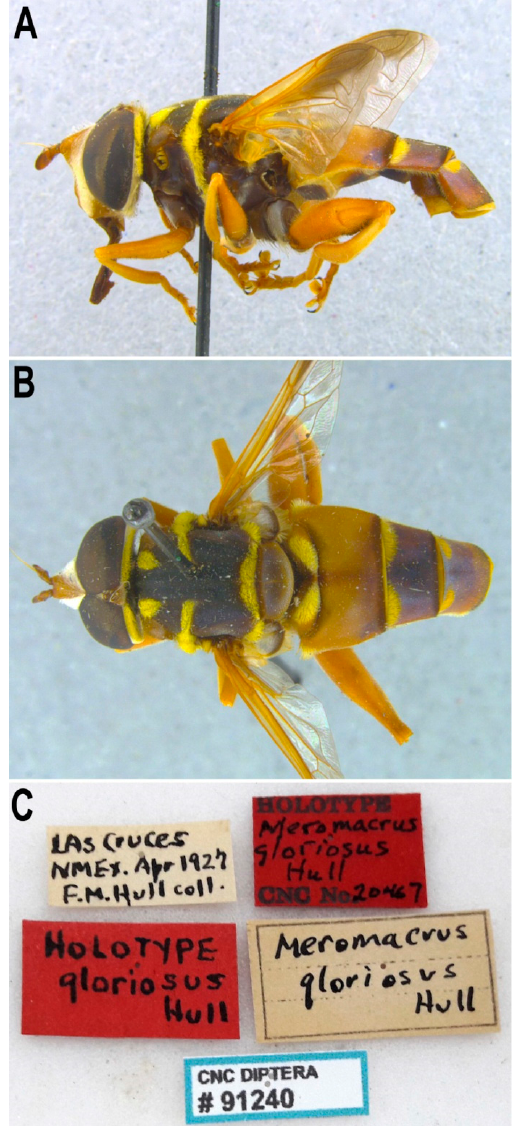
Figure 11. Meromacrus gloriosus , adult, male holotype. ( A ): entire body, lateral view. ( B ): entire body, dorsal view. ( C ): specimen labels.